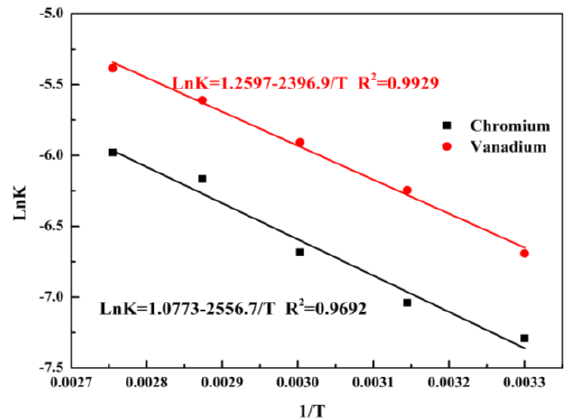
Figure 10. Natural logarithm of reaction rate constant versus reciprocal temperature for leaching Figure10. process.